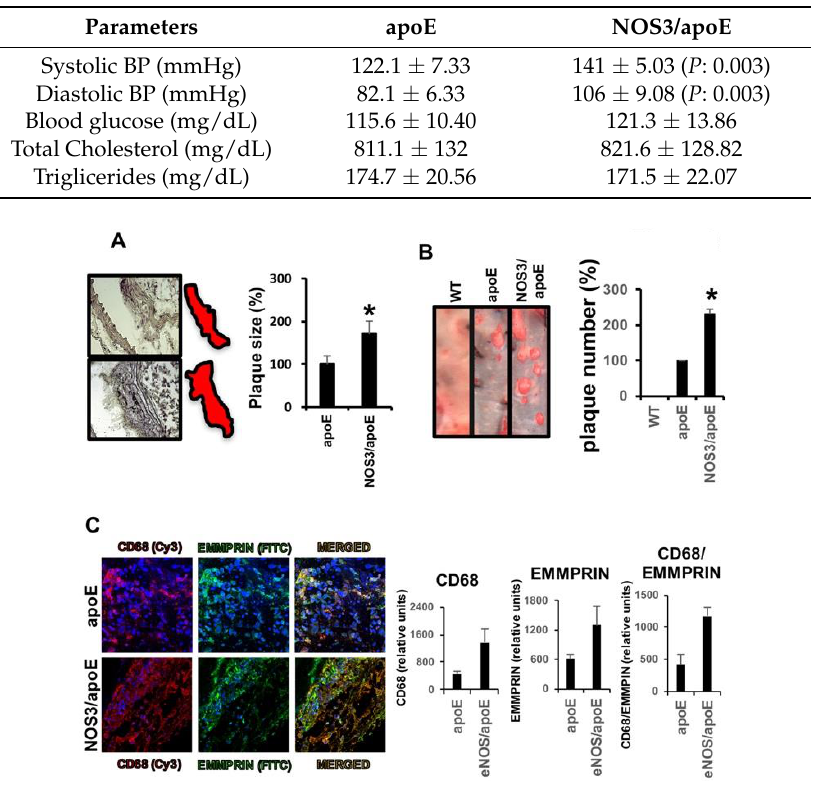
Figure 2. Mice lacking NOS3 show extensive atherosclerotic lesions. ( A ) Hematoxylin/Eosin staining of carotid sections from apoE (upper), and NOS3/apoE null mice (lower), fed with Western-type diet for 12 weeks ( N = 10 mice/group; apoE: 1671 ± 200 vs. NOS3/apoE: 2834 ± 286; * P : 0.002). ( B ) OilRedO staining showing lipid deposition on carotid aortas from the same mice as in ( A ) ( N = 10 mice/group, apoE: 3.25 ± 1.25 vs. NOS3/apoE: 7.5 ± 1.29; * P : 0.003). ( C ) Confocal microscopy detection of CD68 ( N = 10 mice/group, apoE: 452 ± 77.431 vs. NOS3/apoE: 1352 ± 330. * P : 1.27 × 10 − 4 ; Cy3, red), and EMMPRIN ( N = 10 mice/group, apoE: 606 ± 91.113 vs. FITC, green) in carotid sections (Nuclei-Hoecht-blue). Merged panels show co-localization of CD68